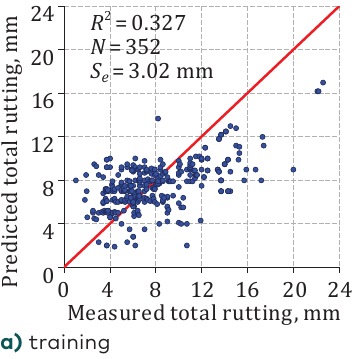
Figure 9. Measured and predicted rutting of